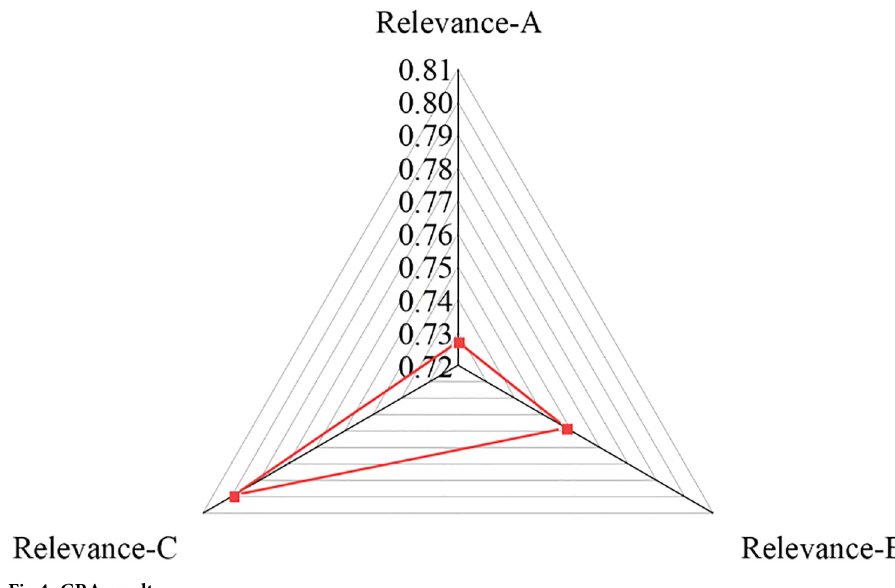
Fig 4. GRA results.